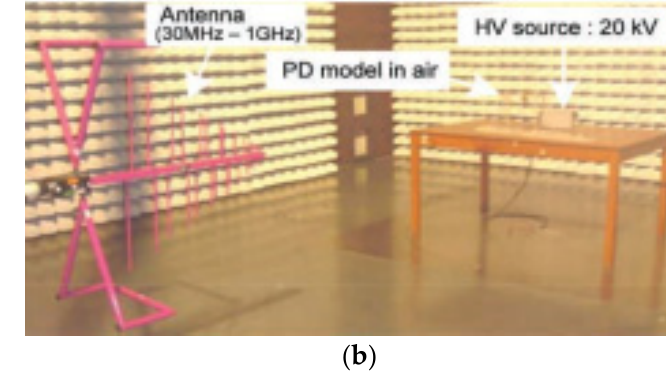
Figure 13. The log ‐ periodic antenna for PD measurement: ( a ) in air with a bandwidth of 150 MHz to 1 GHz [102], and ( b ) inside oil ‐ paper insulation with a bandwidth of 30 MHz to 1 GHz [103]. Ahmed and Srinivas [72] presented an online PD detection technique using a VHF spectrum analyzer in wire ‐ screened and solidly shielded power cables. The suitability and sensitivity of the VHF method were as good as the two alternative PD detection techniques: HFCT and coupling capacitor. Maneerot et al. [103] compared the perfor ‐ mance of a capacitive sensor, used to detect the HF electric field caused by charge trans ‐ fer inside oil–paper insulation due to PD at the defect site, and a VHF/UHF log ‐ periodic antenna used for detecting electromagnetic PD transients in the air outside the trans ‐